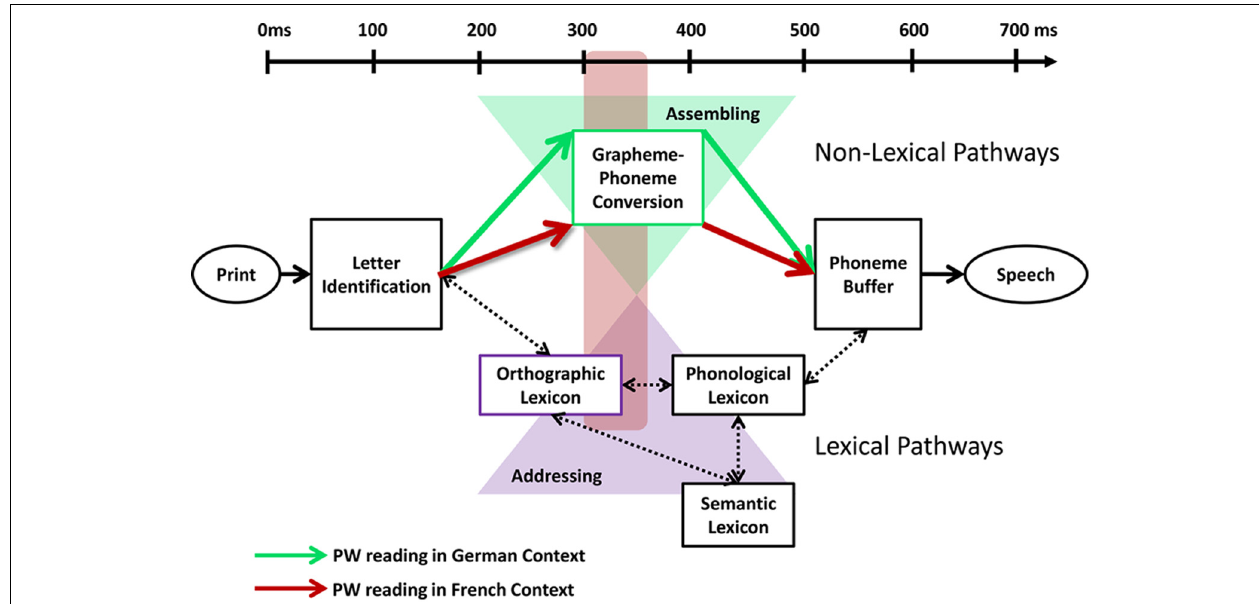
FIGURE 4 |The orthographic depth hypothesis by Katz and Feldman (1983) posits that different reading routes are engaged depending on the type of grapheme/phoneme correspondence of the language being read. Shallow orthographies with consistent grapheme/phoneme correspondences favor encoding via non-lexical pathways (assembled reading; green triangle), where each phoneme is sequentially mapped to its corresponding grapheme. In contrast, deep orthographies with inconsistent grapheme/phoneme correspondences favor lexical pathways (addressed reading; violet triangle), where phonemes are retrieved from memory structures. With regard to this framework, we propose that the